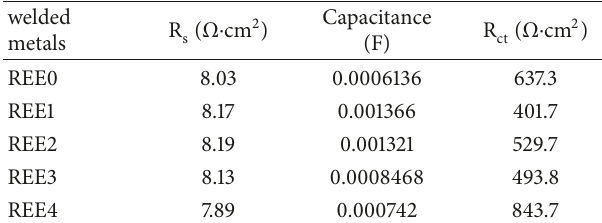
Table 9: Impedance parameters for the EIS-tested welded